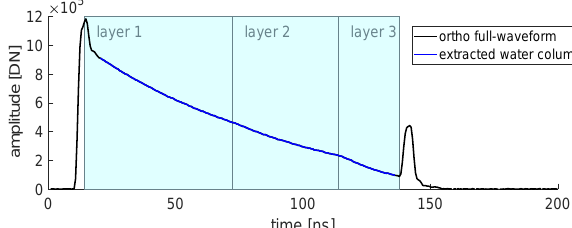
Figure 6. Simulated ortho full-waveform (black) with water column (blue) extracted with full-waveform processing approach presented in Mader et al. (2019, 2021).